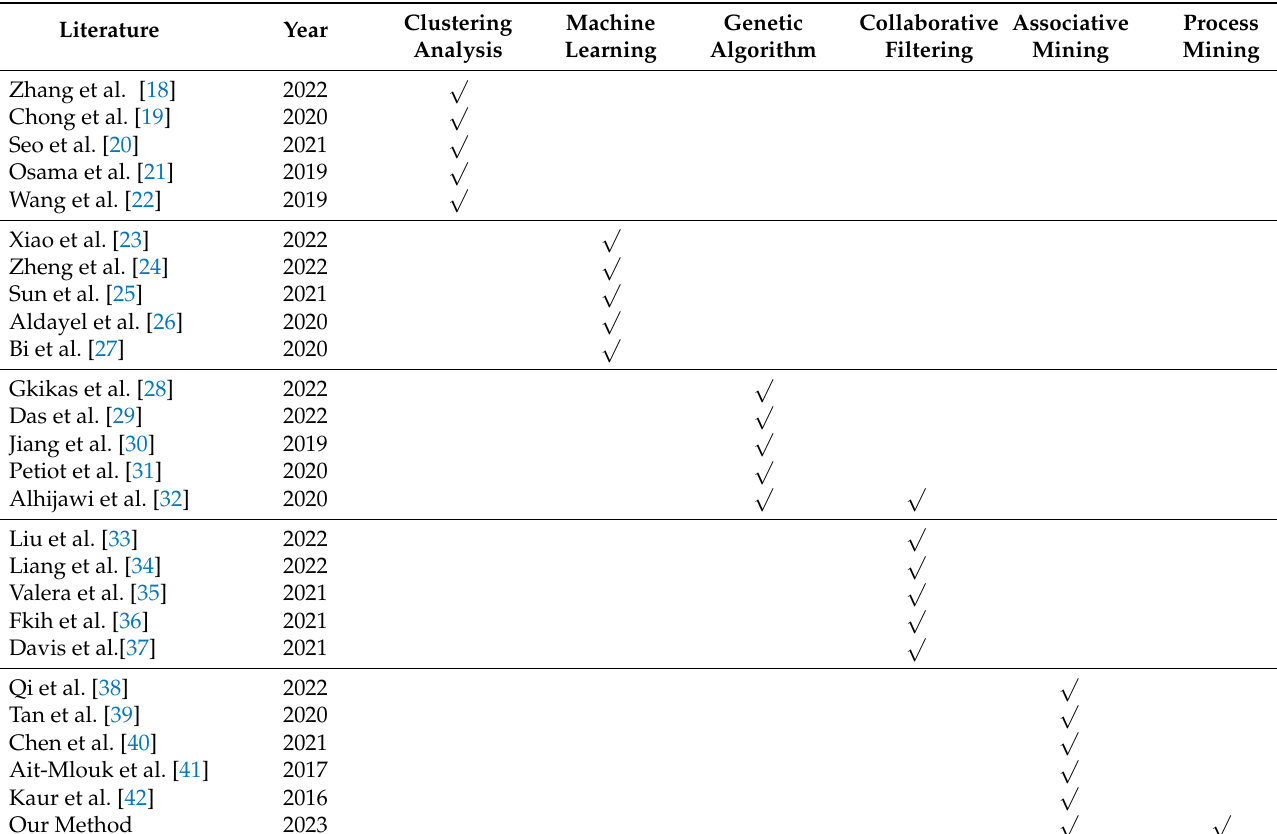
Table 1. Summary of related